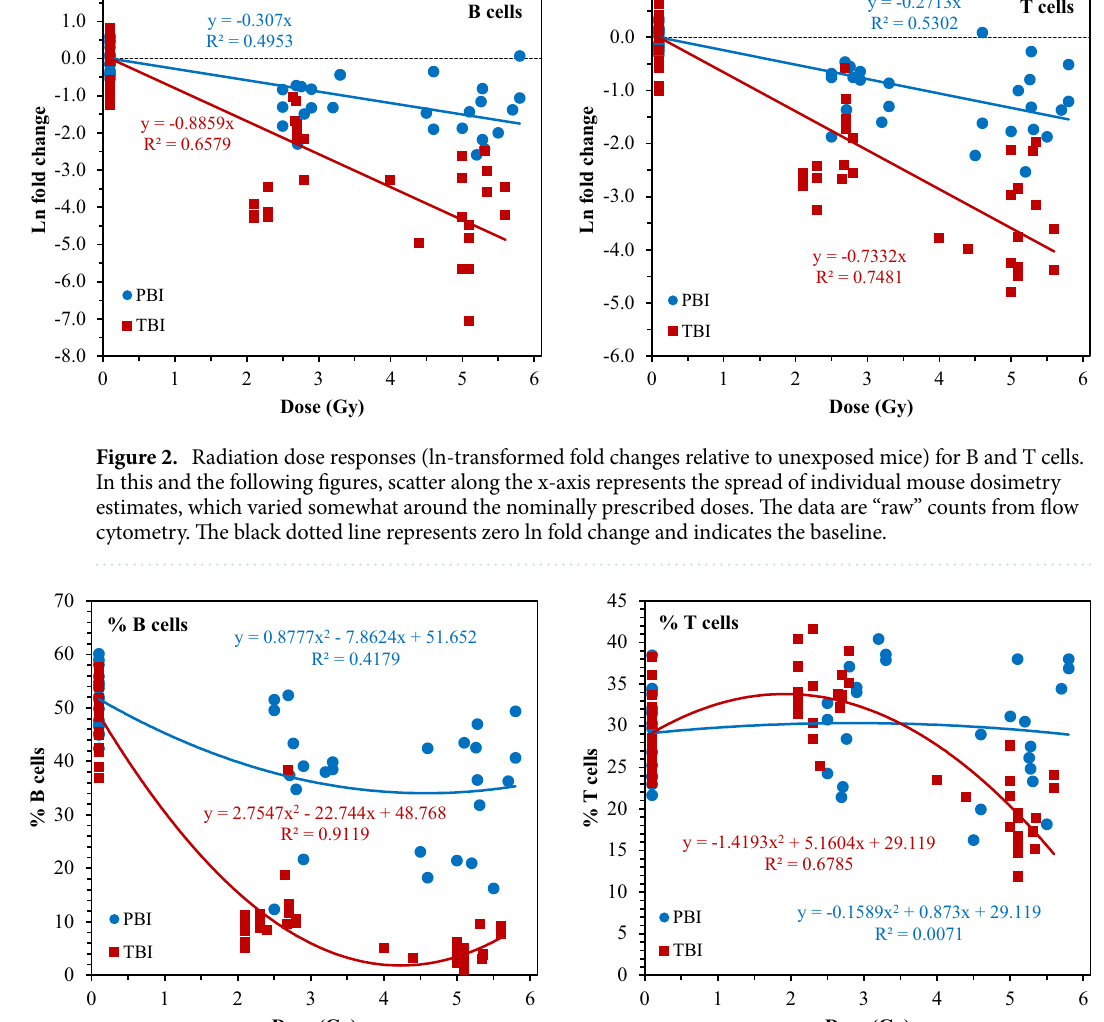
Figure 3. Radiation dose responses for the percentage of cells that display B or T cell surface markers, among all single, focused, and non-apoptotic cells that were acquired. The data shown are "post-processed" counts from